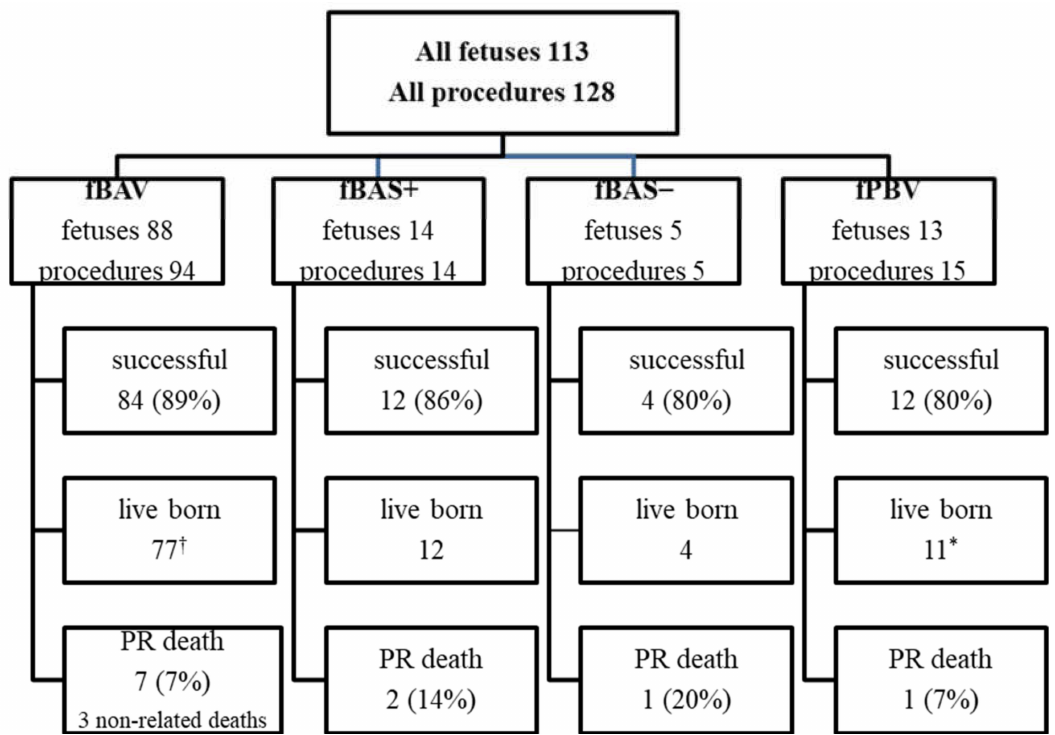
Figure 2. Fetal cardiac interventional procedures performed between 2011 and 2020. fBAV: fetal balloon aortic valvuloplasty; fBAS + : stent placement in the interatrial septum; fBAS − : balloon atrioseptoplasty; fBPV: fetal balloon pulmonary valvuloplasty; PR death: procedure-related death. A total of 14 fetuses had more than one procedure (8 fetuses had the same procedure twice, 5 fetuses had two di ff erent procedures, and 1 fetus had three di ff erent procedures). † two pregnancies continue; * one pregnancy continues. Eight fetuses with critical aortic stenosis were hydropic, and six of them needed opening of the interatrial septum after